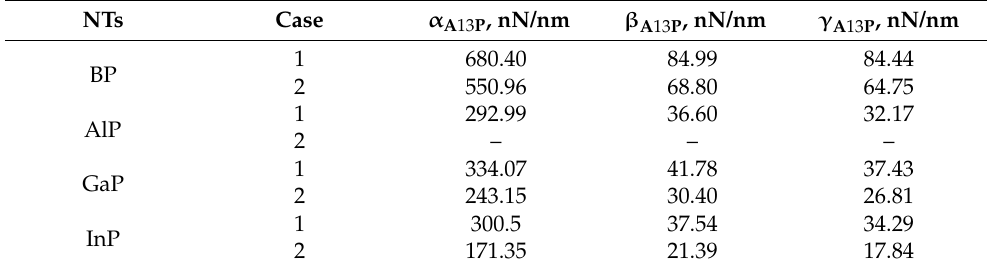
Table 6. Fitting parameters α A13P , β A13P and γ A13P for phosphide nanotubes.